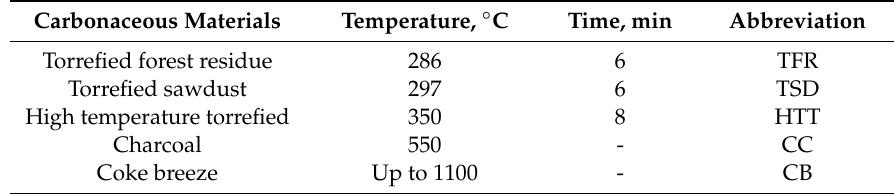
Table 1. Selected carbonaceous materials with abbreviations and their pretreatment temperatures and time.